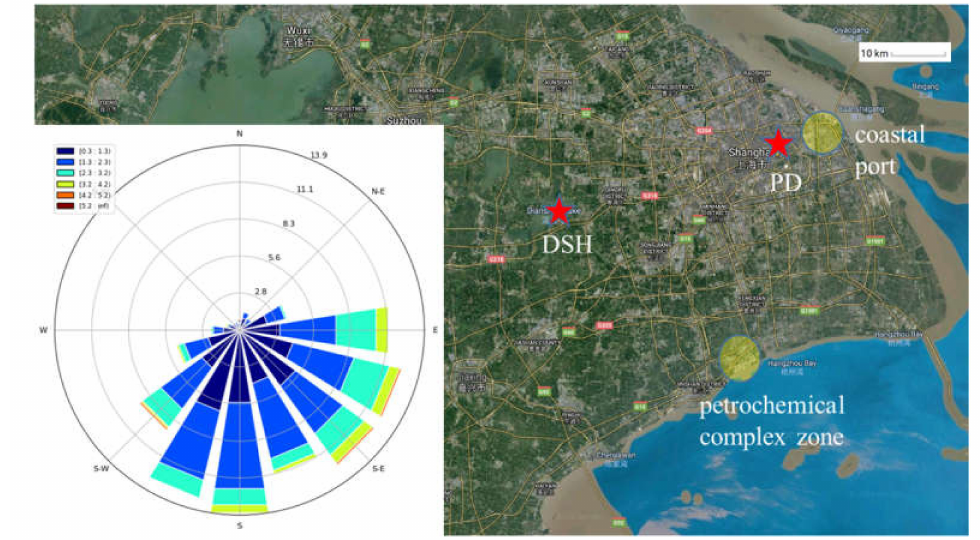
Figure 1. Map of the Pudong (PD) and Dianshanhu (DSH) sites in Shanghai. The wind rose in the bottom left shows the probability of wind speeds and directions in Shanghai from 1–31 July